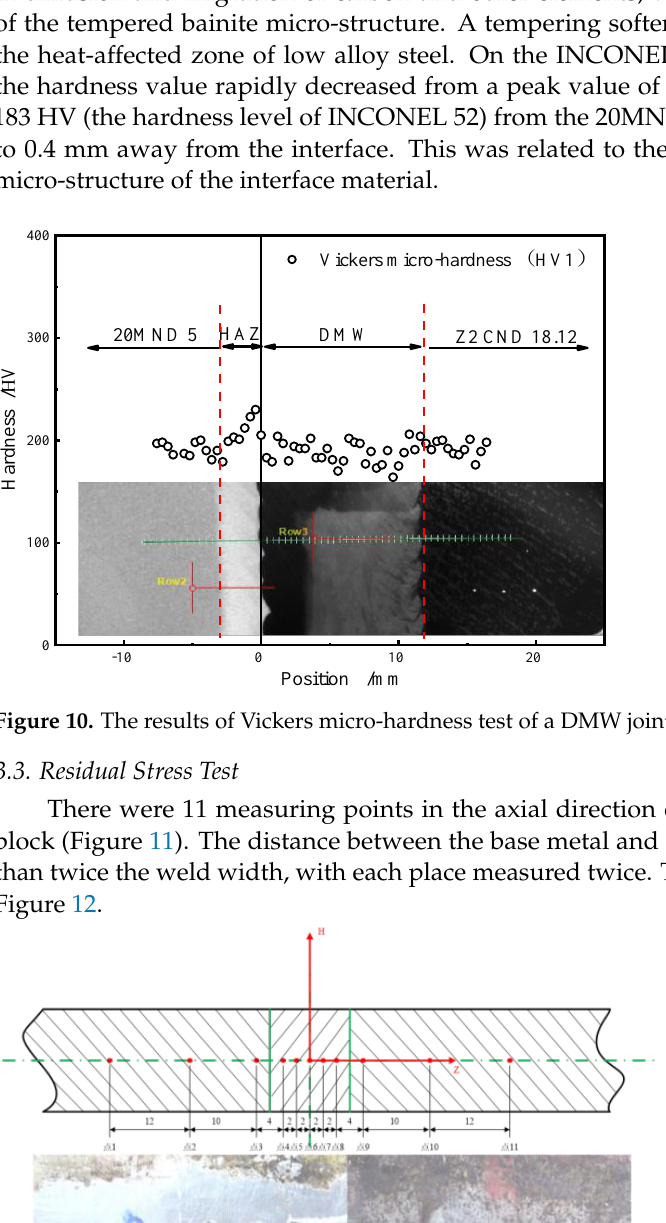
Figure 12. Location of residual stress measuring points on the outer wall of the test block. It can be seen from Figure 12 that the highest residual stress of the dissimilar metal welded joint of narrow-gap automatic welding is in the heat-affected zone on the side of low alloy steel. The residual stress was low because the dissimilar metal weld underwent 4 h of intermediate tempering from 250 °C to 400 °C and a final heat treatment from 595 °C to 620 °C for 2.75 h to 3.25 h. 3.4. EBSD Analysis Figure 13 shows the inverse pole figures (IPFs), kernel average misorientation (KAM) maps and grain boundary character distribution (GBCD) maps in BMs, the HAZ of the 20MND 5, the FB region of the 20MND 5/INCONEL 52 dissimilar welding structure, WM INCONEL 52, and theFB region of the INCONEL 52/Z2 CND 18.12 N2-controlled and Z2 CND 18.12 N2-controlled dissimilar welding structures. This shows that the residual stress in the heat-affected zone of 20MND 5 is high, which was in good agreement with the test results in Figure 12. -30